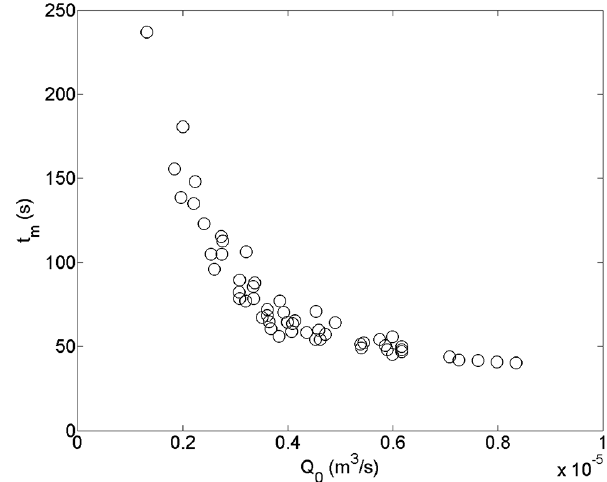
Figure 5. Mean travel time t m (s) versus injection flow rate Q 0 (m 3 s − 1